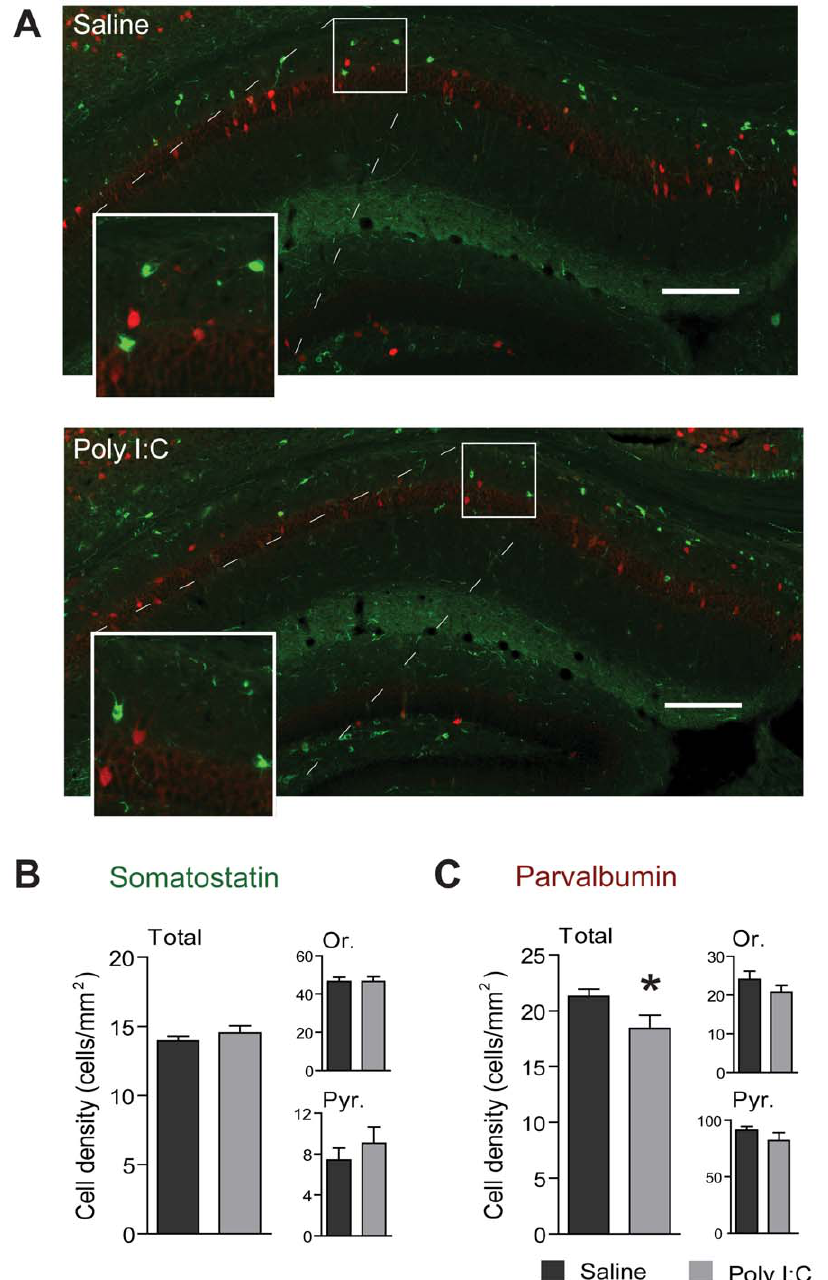
Figure 1. Reduced density of parvalbumin-expressing interneurons in CA1 caused by prenatal immune challenge. A ) Photomicrograph of the CA1 subfield of the hippocampus from pups of dams treated with poly I:C during pregnancy (bottom) and control (top). Scale bar 200 m m, in green: somatostatin, in red: parvalbumin. B ) and C ) Comparison of somatostatin- (B) and parvalbumin- (C) positive cell density between the poly I:C and the saline group, for all the CA1 subfields (total), stratum oriens (Or.) or stratum pyramidale (Pyr.) (saline n=8, poly I:C n=6).